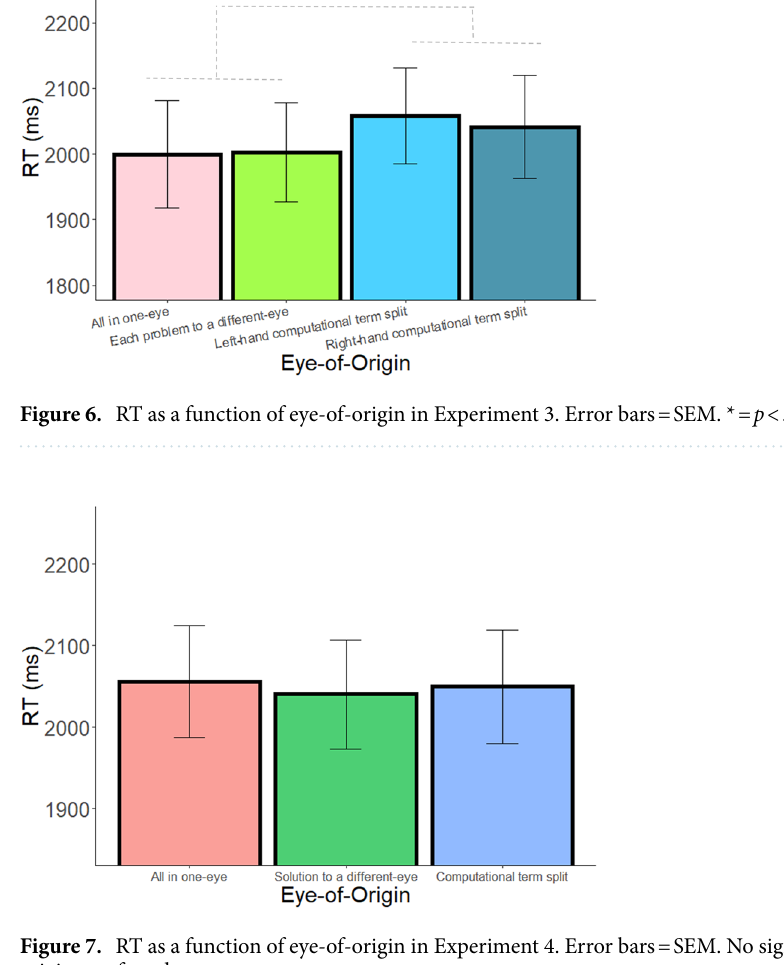
Figure 7. RT as a function of eye-of-origin in Experiment 4. Error bars = SEM. No significant effect of eye-of- origin was